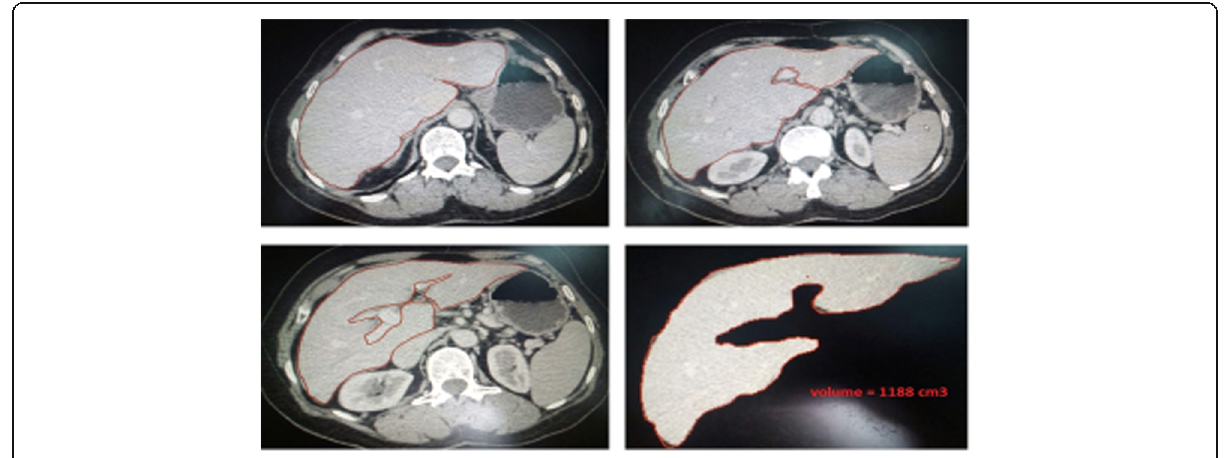
Fig. 1 Example of semi-automated CT volumetry